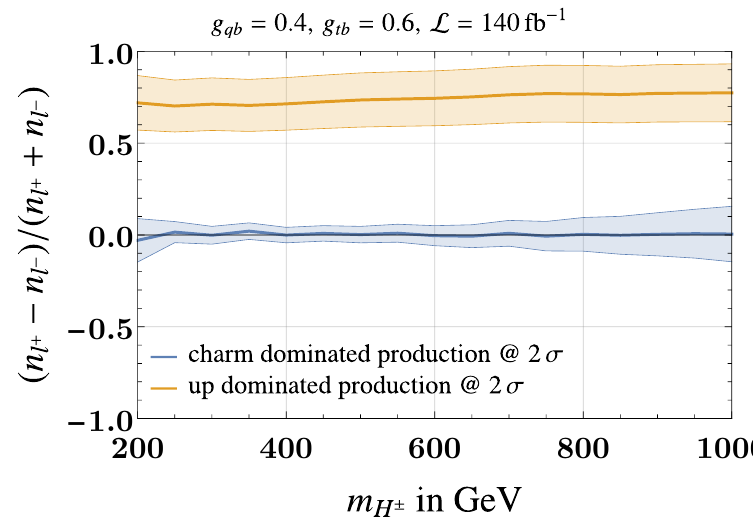
Figure 12 . Charge asymmetry for the charged Higgs signature (in bbb‘ ) for the cases of pure ub (orange) or cb (blue) production, as a function of the charged Higgs mass. The production through the ub coupling displays a significant charge asymmetry due to the initial state valence quark. We also display combined statistical and systematic uncertainties, with the latter assumed to be 10%